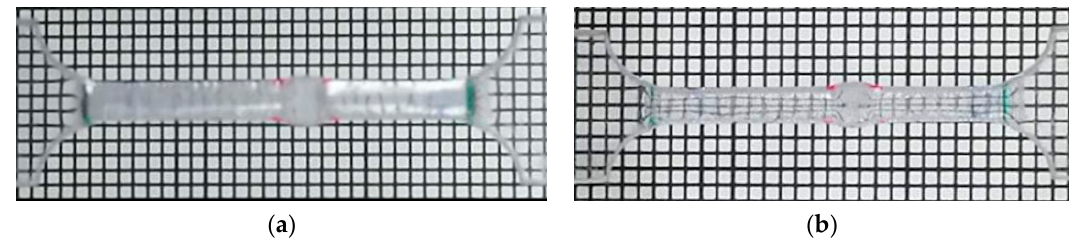
Figure 16. Lens effect in the sample programmed to 100% strain at 128 °C. ( a ) 56.5 mm above the grid paper (blur); ( b ) 13 mm above the grid paper (clear).